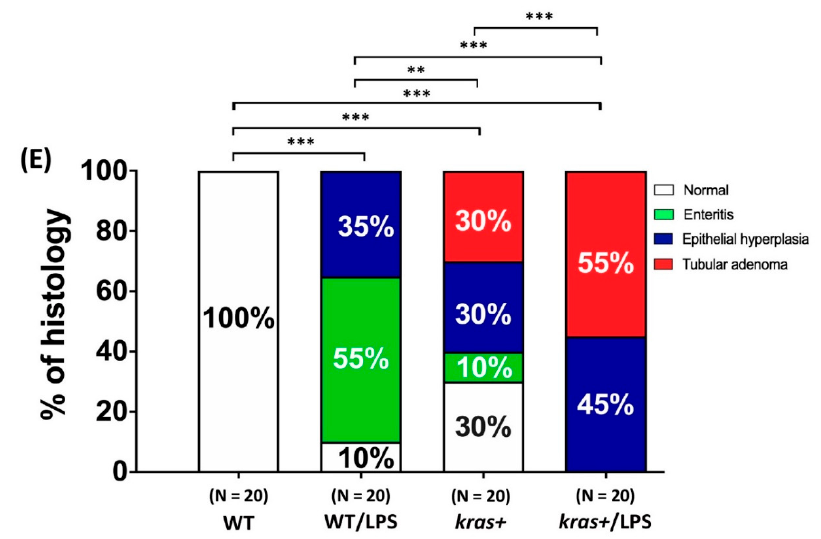
Figure 2. Synergistic effect of kras V 12 expression and LPS treatment in intestinal tumorigenesis. Four-month-postfertilization WT and kras+ zebrafish were cotreated with 2 µ M of mifepristone and 40 ng/mL of LPS for 4 weeks, and samples were then collected for gross observations and histological analyses. There were four experimental groups: WT, WT/LPS, kras+, and kras+/LPS. ( A , B ) Body length and body weight. ( C ) Survival curves. ( D ) Examples of normal intestines, enteritis, hyperplasia, and tubular adenoma as revealed by H&E-stained sections of the intestine. ( E ) Summary of intestinal histological abnormalities observed in the four experimental groups. These data were generated from results of a blinded histological analysis (WT, n = 20; WT/LPS, n = 20; kras+, n = 20; kras+/LPS, n = 20). Differences among the variables were assessed using Student’s t-tests or one-way ANOVA. Statistical significance: * p < 0.05, ** p < 0.01, *** p < 0.001. Scale bar: 50 μ m.